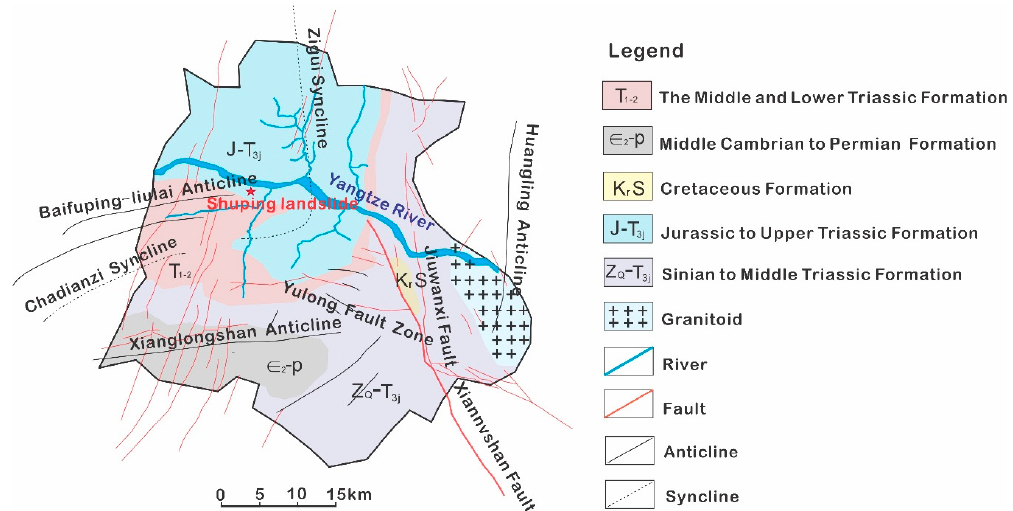
Figure 1. Geological map in the Shuping landslide area. Int. J. Environ. Res. Public Health 2020 , 17 , x